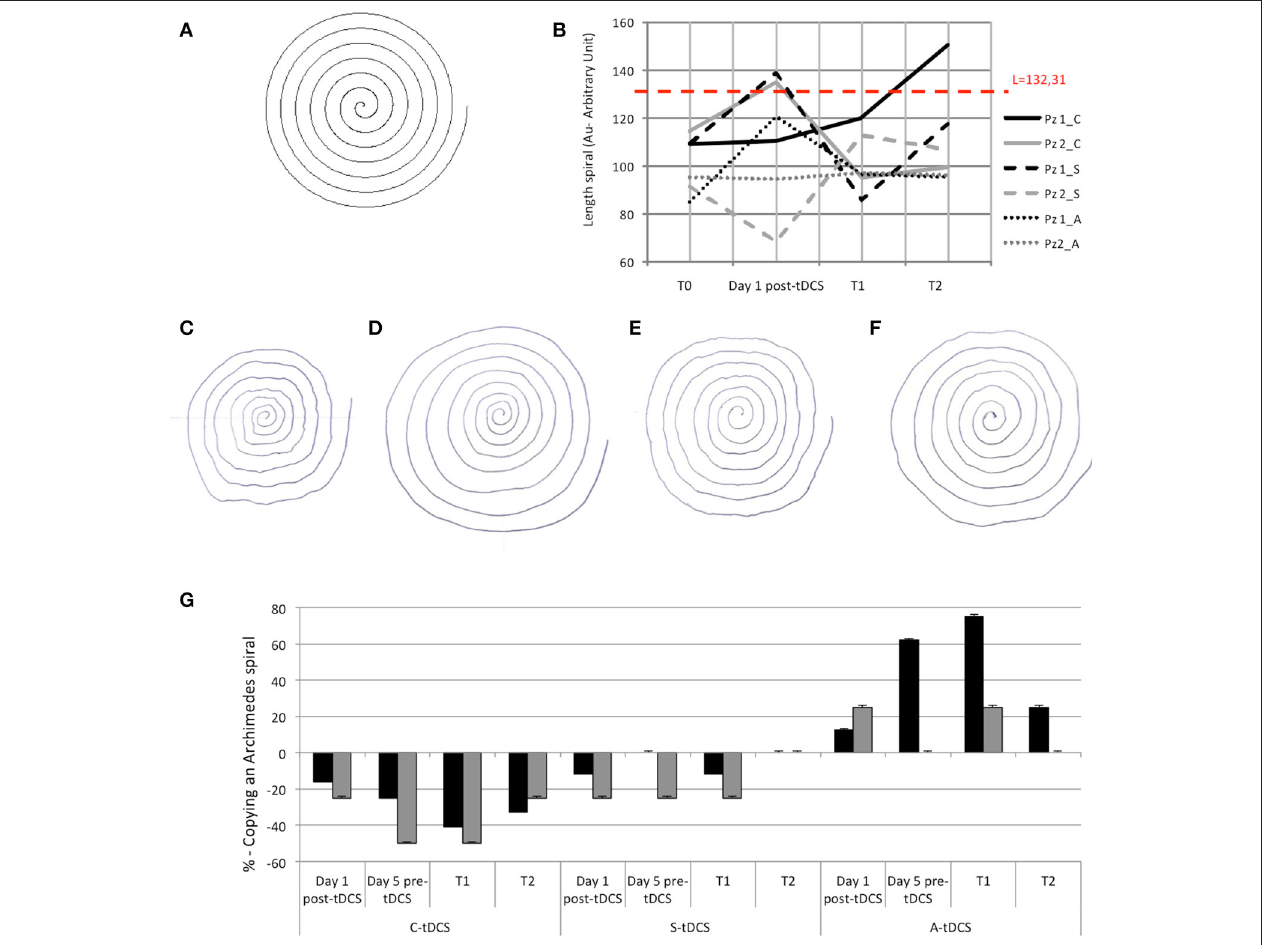
FIGURE 2 | (A) Copy of an Archimedes spiral task: template of Archimedean Spiral; (B) The lines show quantitative evaluation in both patients at T0, at day 1 after tDCS, at T1, and at T2. The red dashed line is the length of the sample spiral (132.31 mm), black lines refer to patient 1 and gray lines to patient 2. The full is C-tDCS, the dashed line is A-tDCS and the dotted line s S-tDCS session; (C) Copy of Archimedean Spiral the first day after C-tDCS treatment in patient 1; (D) Copy of Archimedean Spiral at T1 of the C-tDCS session in patient 1; (E) Copy of Archimedean Spiral at the first day after A-tDCS treatment in patient 1; (F) Copy of Archimedean Spiral at T1 of the A-tDCS session in patient 1. (G) The histogram shows tremor in qualitative analysis in the percentage differences after tDCS in both patients. 0% is baseline (pre-tDCS—T0).